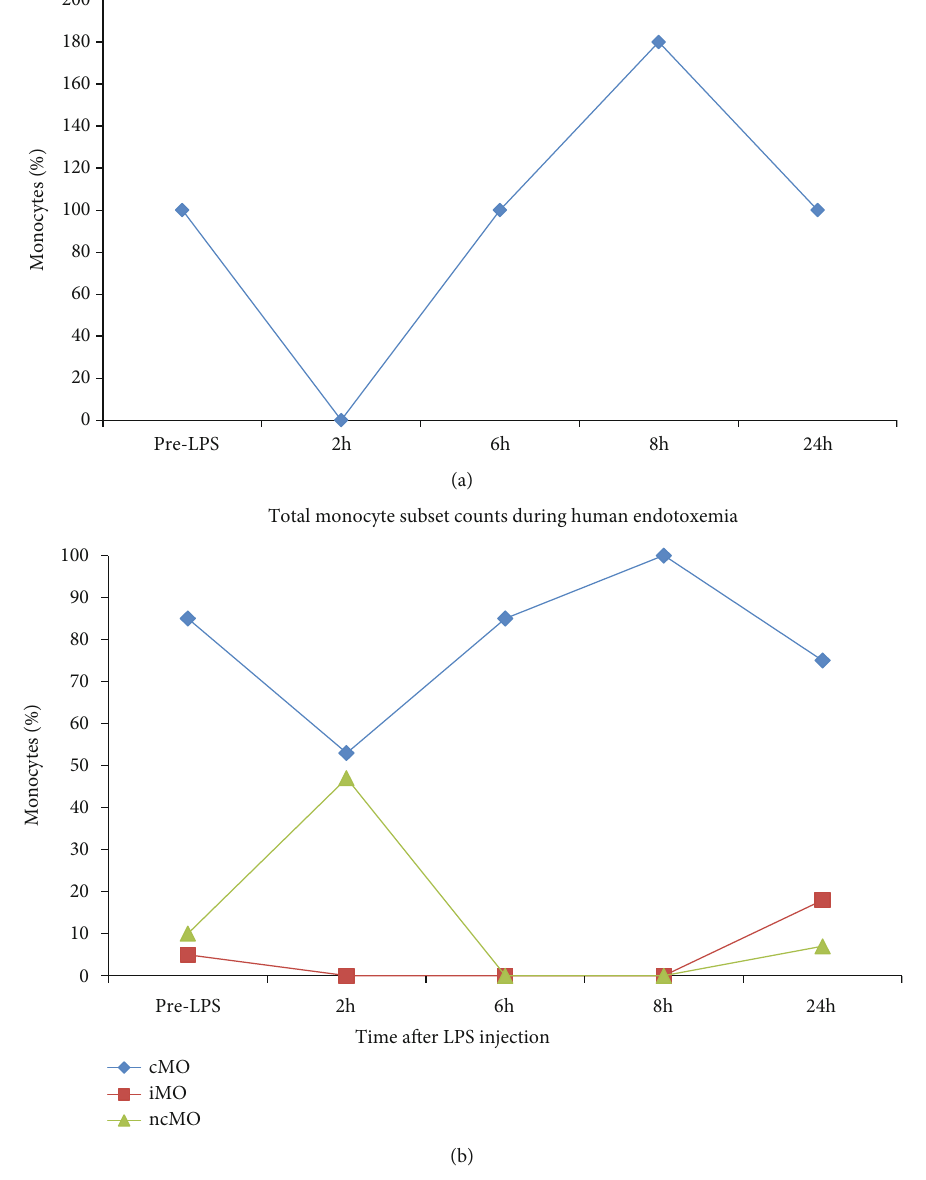
Figure 2: Monocytes in experimental endotoxemia. Total monocyte percentages (a) are decreased at 1 – 1.5h after LPS injection, and cell count increases at 6 – 8h after LPS injection. Monocyte subset percentages (b) show that classical monocytes (cMo) comprise 80 – 90% of all monocytes. cMo percentages follow those of total monocytes. Intermediate monocyte (iMo) and nonclassical monocyte (ncMo) percentages are decreased 1 – 8h after LPS injection with a trend towards higher iMo percentage at 24 h after LPS injection [7,